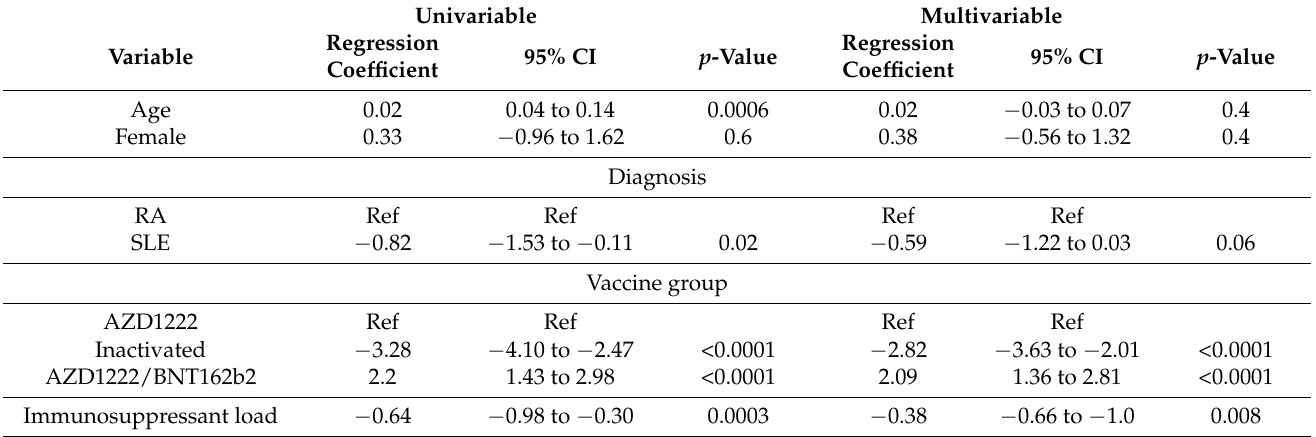
Table 3. Linear regression models for natural log-transformed anti-RBD antibody at 28 days after the second